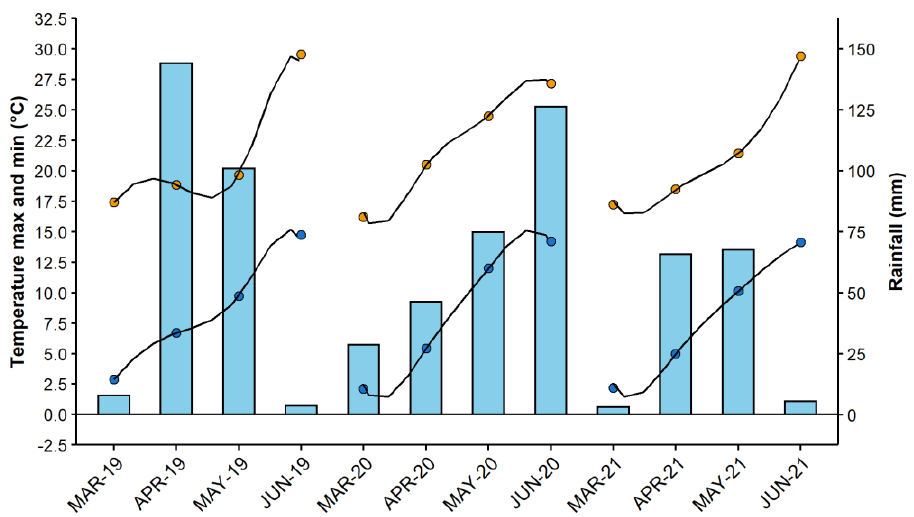
Figure 1. Seasonal climate in San Piero a Grado during the years of the experiment, from March 2019 to June 2021. On the left y -axis is the maximum (top lines) and minimum (bottom lines) monthly average temperatures and on the right y -axis is the monthly average rainfall.